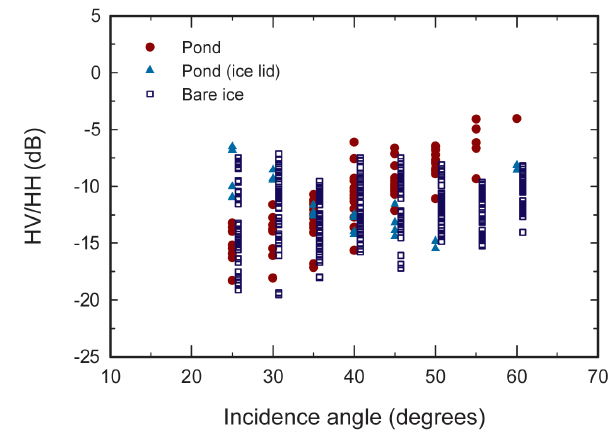
Figure 8. Scatterometer measured VV / HH versus incidence angle, from surface types pond, pond (ice lid) and bare ice. Pond sam- ples were taken from Database B. Also shown are IEM simulated VV / HH for ponds, with numerical values corresponding to the s w (in mm) used to initiate the model, and VV / HH for bare ice under cold/dry and warm/wet conditions. Bare ice observations are offset along the x axis by 1 ◦ for clarity.